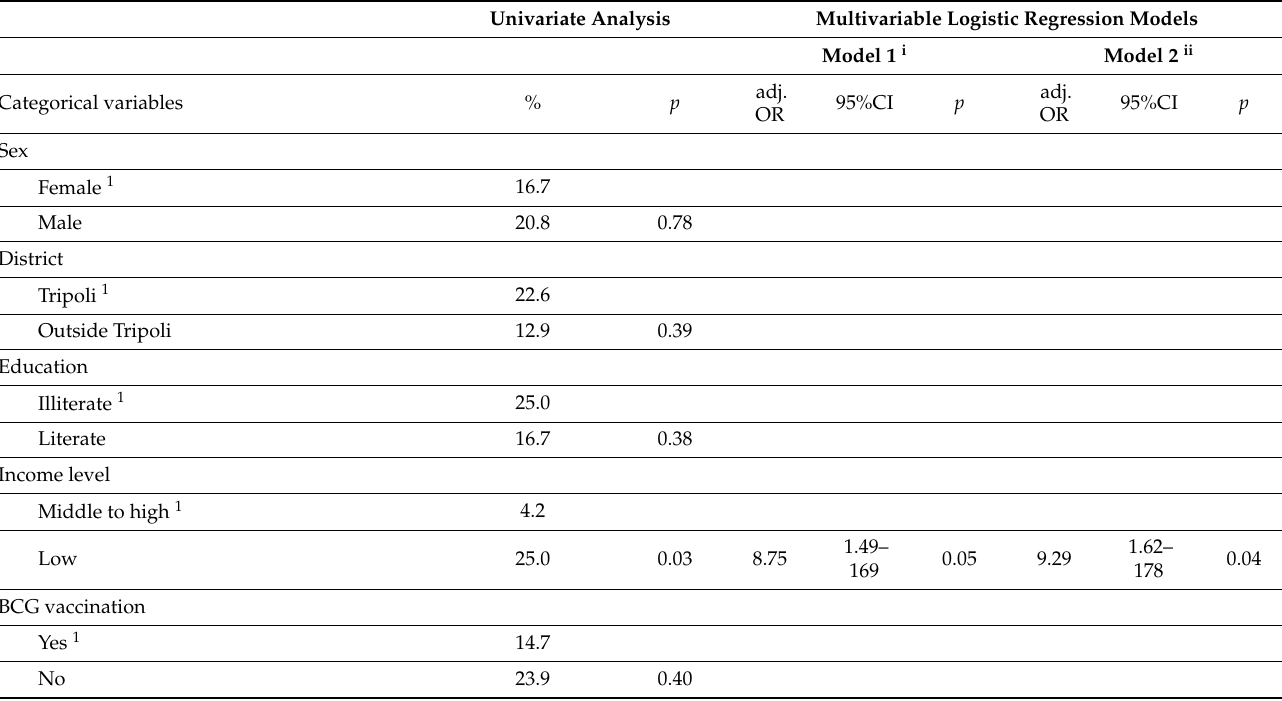
Table 2. Determinants of latent tuberculosis among patients on hemodialysis using univariate analysis and multivariable logistic regression